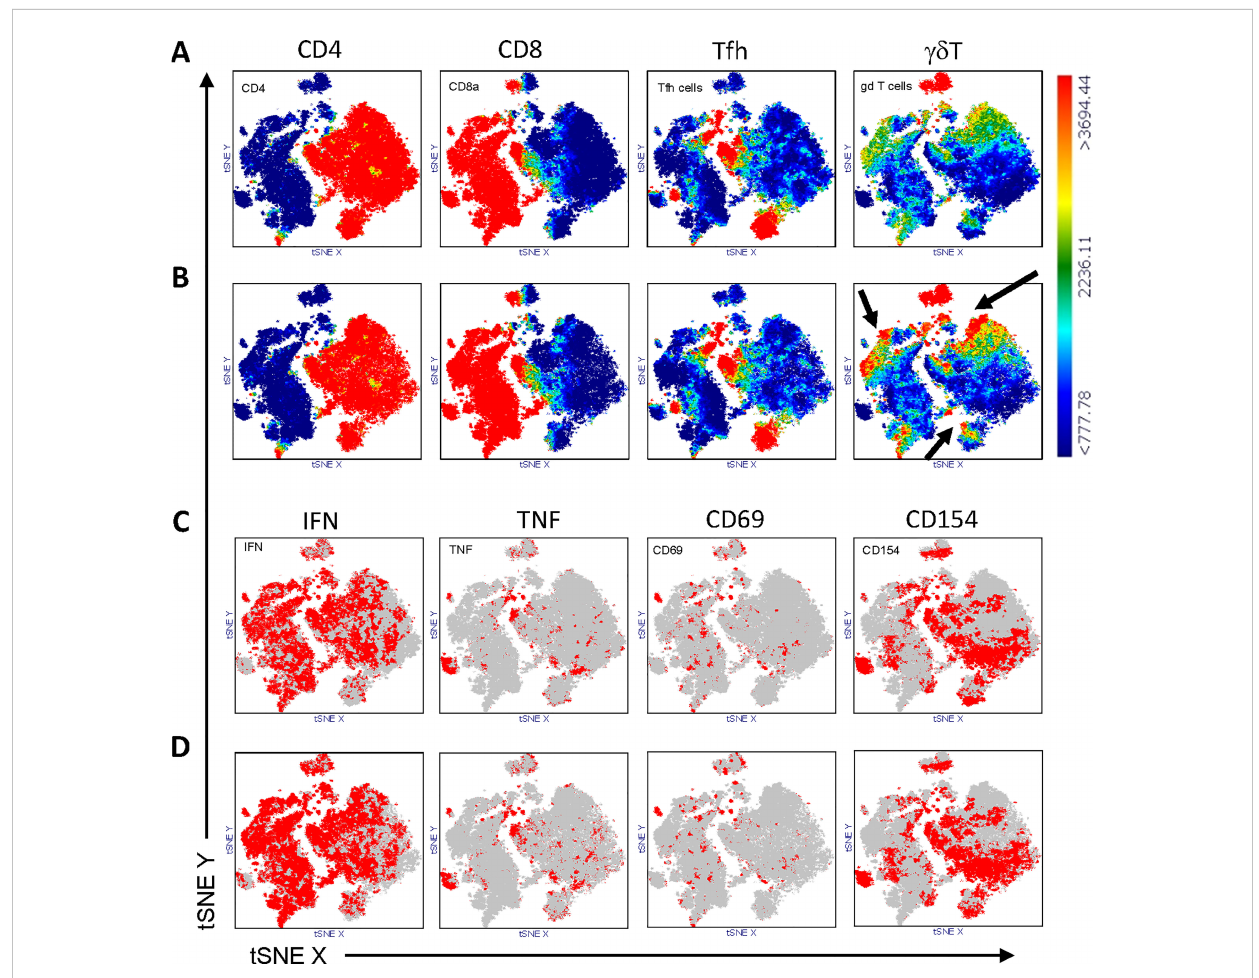
FIGURE 2 Distribution of T cell subtypes within CD3+ T cells in controls (A) and patients (B) and distribution of S-Peptides-activated cells in controls (C) and patients (D) . T cells from controls (N=12) and patients (N=12) were concatenated and subjected to unsupervised analysis by t-distributed stochastic neighbor embedding (t-SNE), color-coded for the expression of CD4, CD8, CXCR5 (Tfh cells), gd TCR ( gd T cells) from blue (low) to red (high), (A, B) and for the expression of IFN, TNF, CD69 and CD154 from grey (<1000) to red (>1000), (C, D) . To be noted, the higher abundance of gd T cells in patients (B) compared to controls (A) is highlighted by